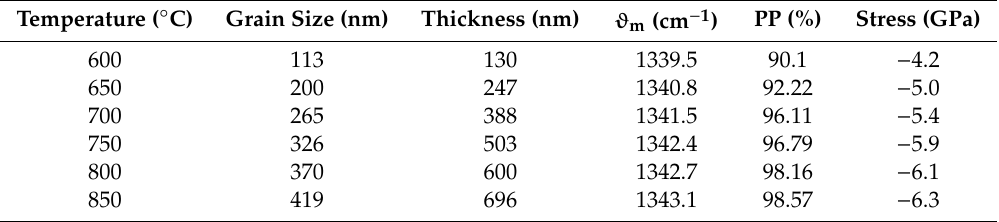
Table3. Grainsize, thickness, Ramanpeak, phasepurity, andstressofdiamondatdi ff erenttemperatures. Temperature ( ◦